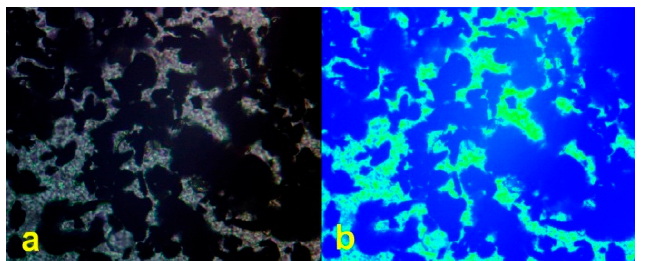
Figure A1. Typical clumped packing structure of Fe 0 grains and associated porosity in a Fe 0 column. Transmitted light. Macro pores occupy 22% of the visible porosity. Field of view = 0.93 mm. ( a ) Transmitted light. Fe 0 = black, porosity = grey; ( b ) Pseudo-color analysis. Fe 0 = Blue. Porosity = green.